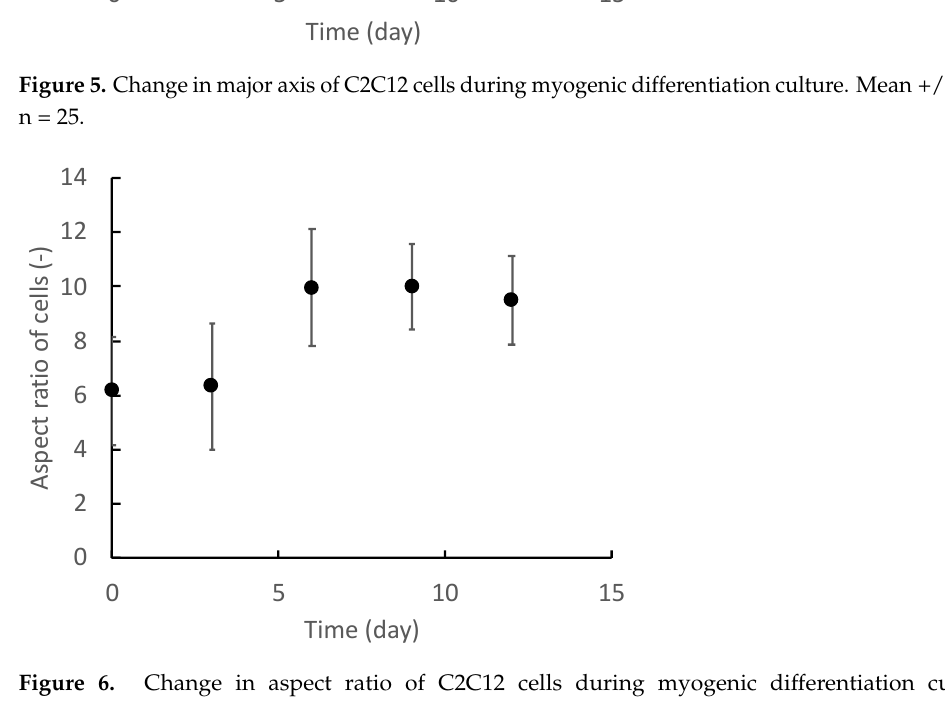
Figure 6. Change in aspect ratio of C2C12 cells during myogenic differentiation culture. Mean +/ − SD, n = 25.